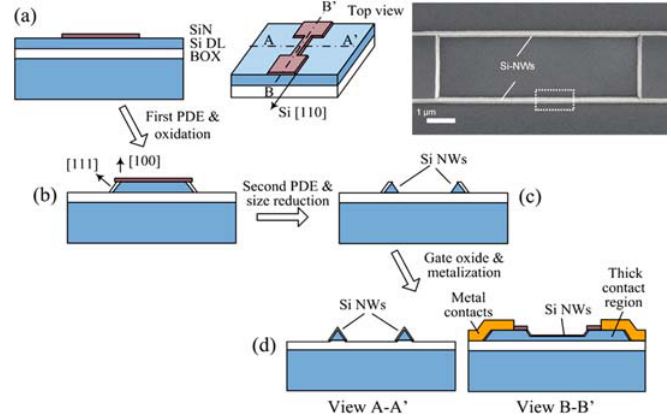
Figure 5. Illustration of SiNWs fabrication using the size reduction method: ( a ) a SiN layer is deposited and then dry ‐ etched to form the mask; ( b ) a plane dependent etching (PDE) is performed to etch out the exposed Si layer followed by oxidation at the [111] side; ( c ) a second PDE and size reduction process are used to realize the SiNWs; and ( d ) the SiNW device is completed through formation of the gate oxide and metallization of the contacts. Inset: SEM image of the resulting triangular SiNWs. Reprinted with permission from Ref. [32]. Copyright (2009), ACS.